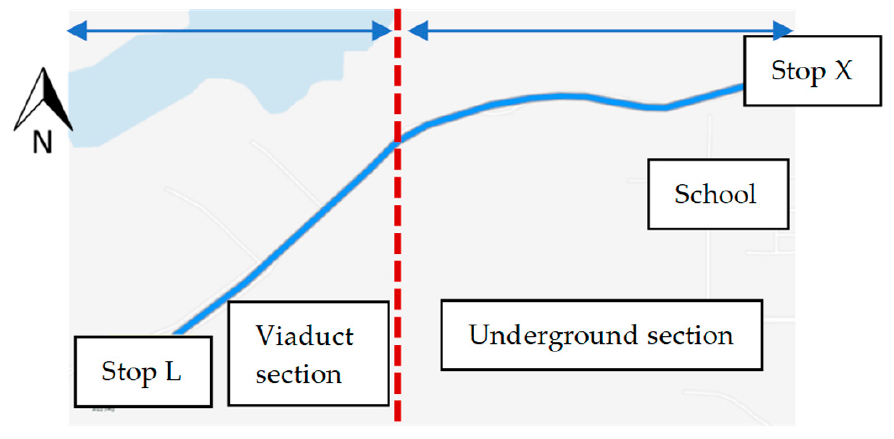
Figure 17. Layout of the field test route.